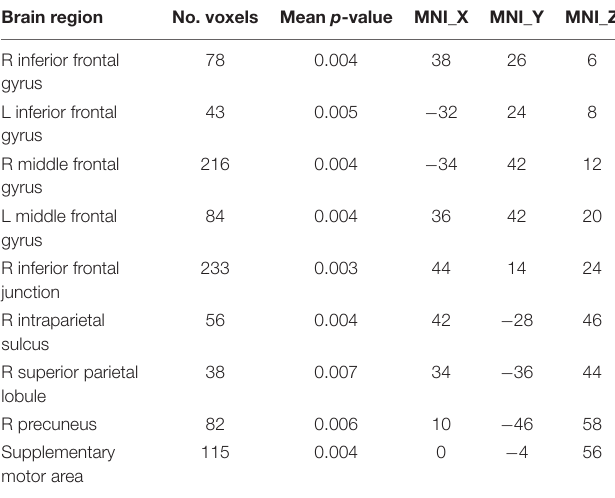
TABLE 1 | FFA connectivity comparisons (contrast: Fcue_Ftarget > Scue_Ftarget). Brain region